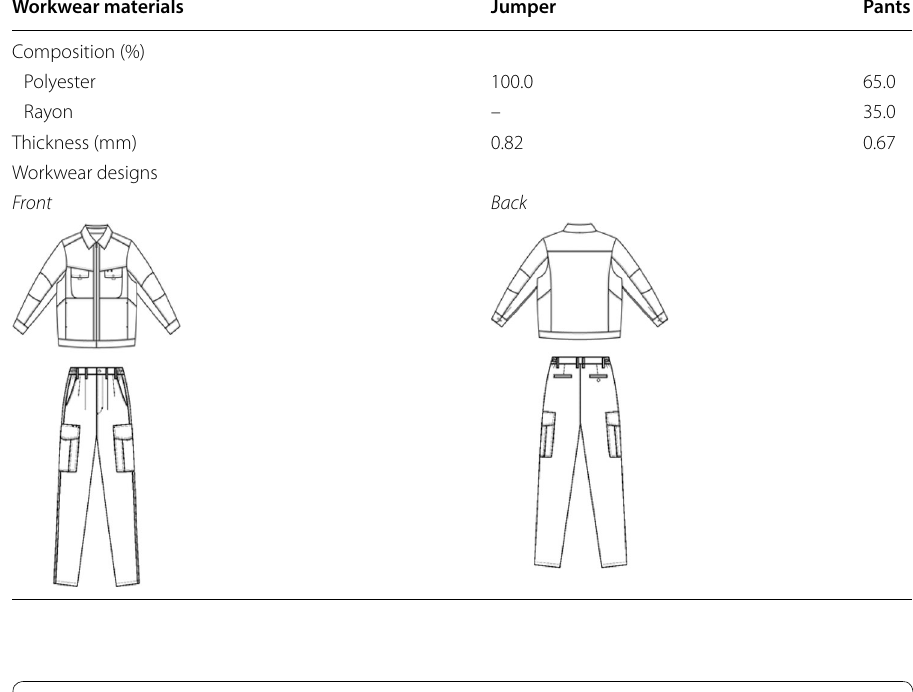
Table 2 Fabric contents and designs of workwear worn by the subjects Workwear materials